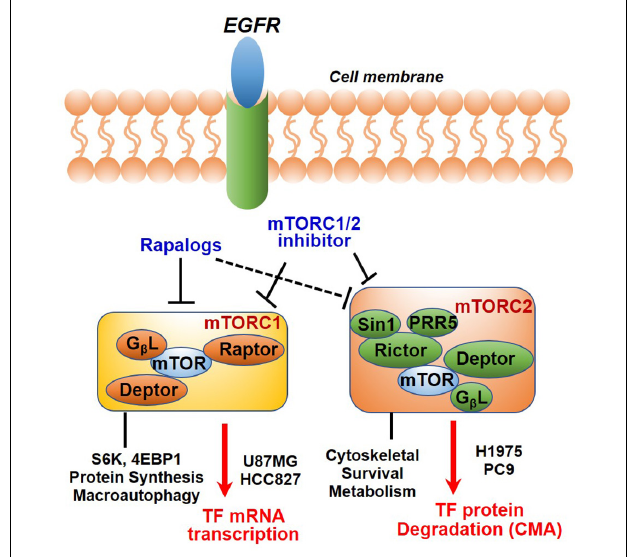
FIGURE 7 | Diagram showing EGFR to mTOR signaling network and effects of mTOR inhibitors on TF regulation. In EGFR-mut cancer cells, mTOR kinase inhibitor acutely targets both mTORC1 and mTORC2, while rapalog primarily targets mTORC1 but can also disrupt mTORC2 upon a prolonged treatment. As shown, mTOR inhibitors differentially modulate TF expression in a cellular context-dependent manner. mTORC1 promotes TF mRNA transcription in HCC827 and U87MG cells; An mTORC2-dependent suppression of chaperon mediated autophagy (CMA) mechanism is proposed for up-regulation of TF protein in H1975 and PC9